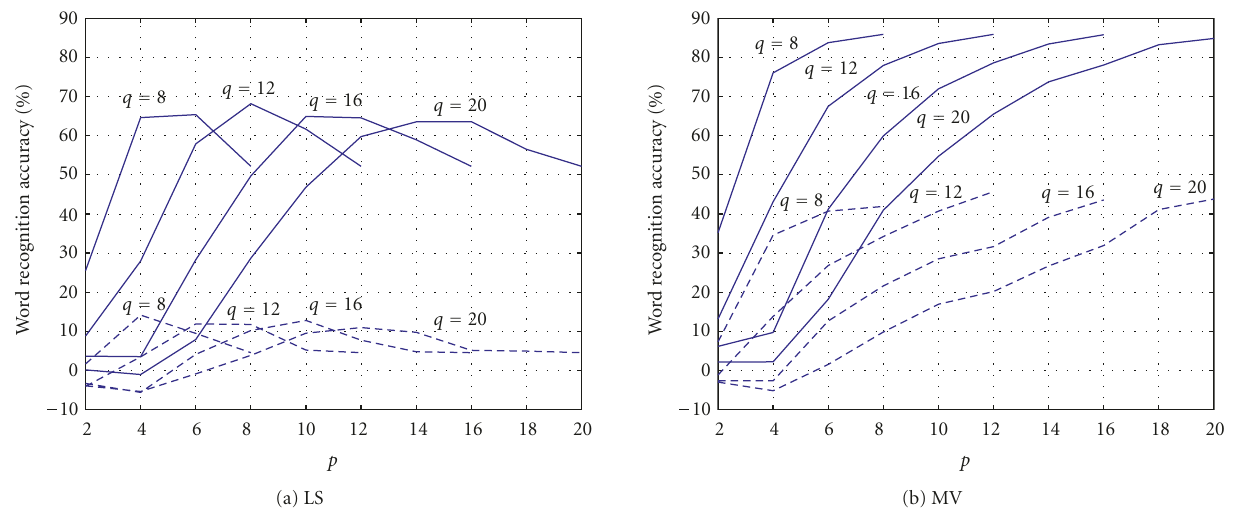
Figure 4: Word recognition accuracy for the SVD-based enhanced signal as a function of the order p of the enhanced Hankel matrix, for di ff erent values of q . A solid line is used for noisy speech at 20dB SNR and a dashed line for 10dB SNR. (a) LS estimator. (b) MV estimator (representative of all estimators that perform noise reduction in the signal